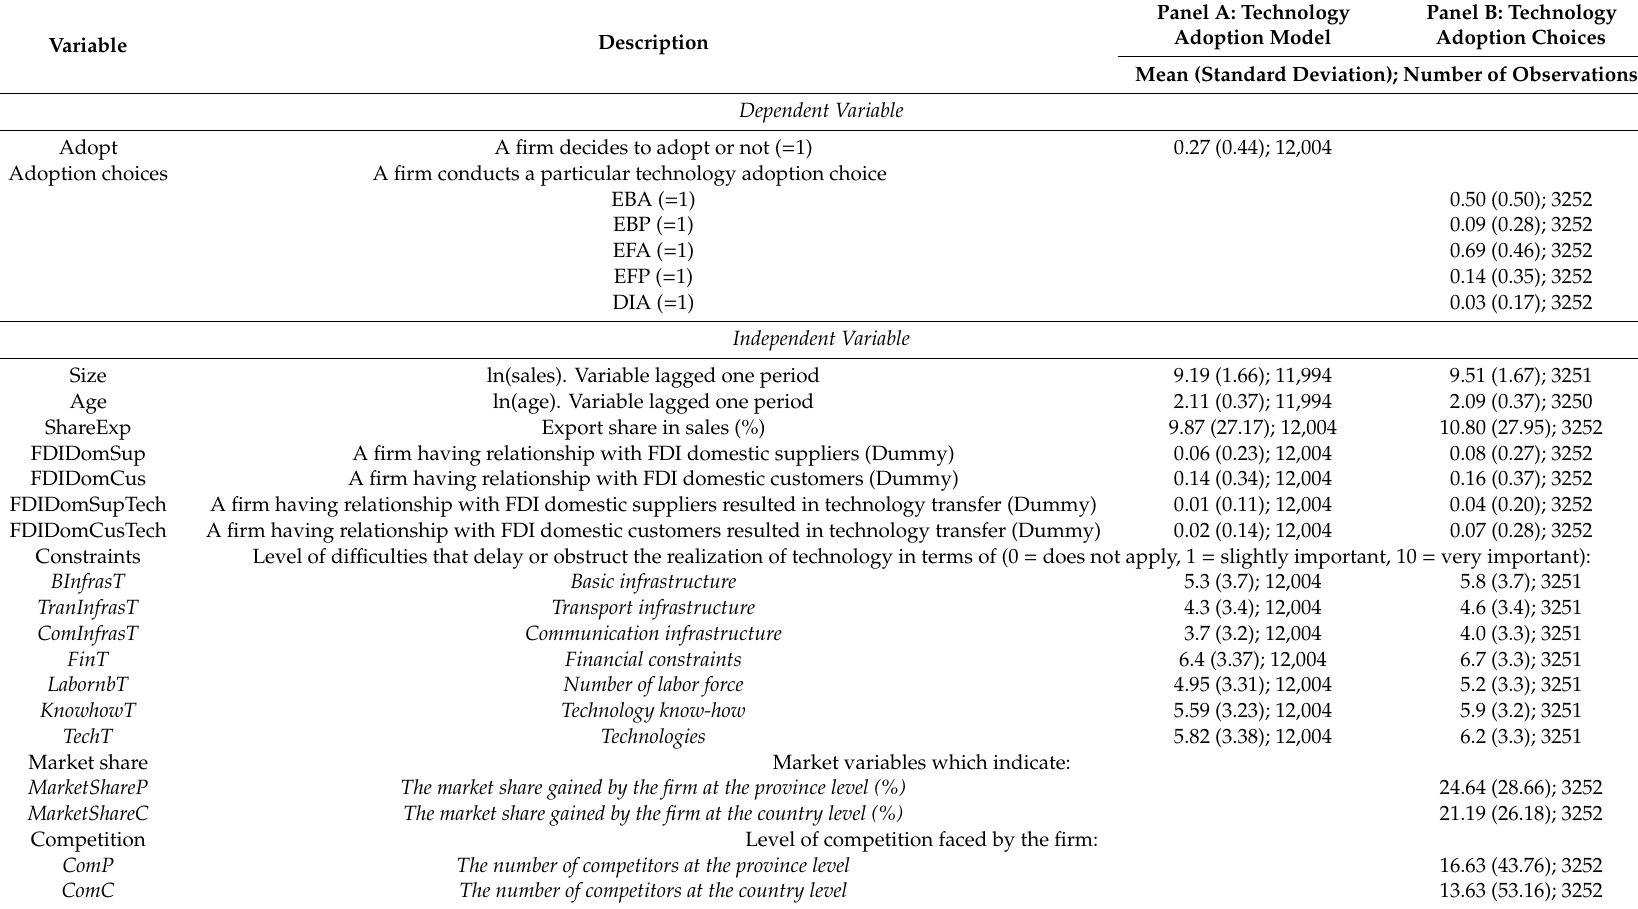
Table 1. Variables in the technology adoption model and the model of particular technology adoption